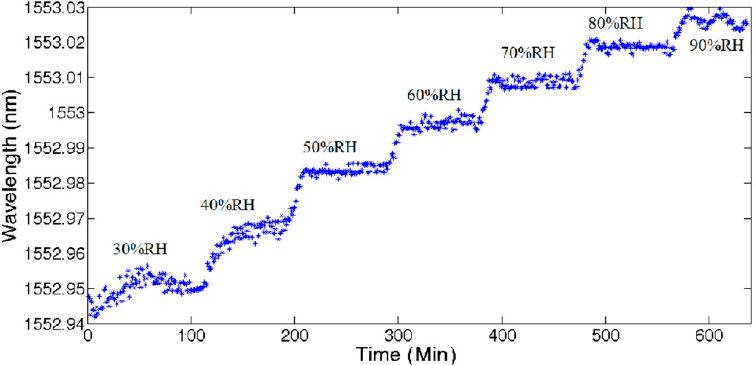
Figure 9. UFBG2 central wavelength evolution with the change of relative humidity .